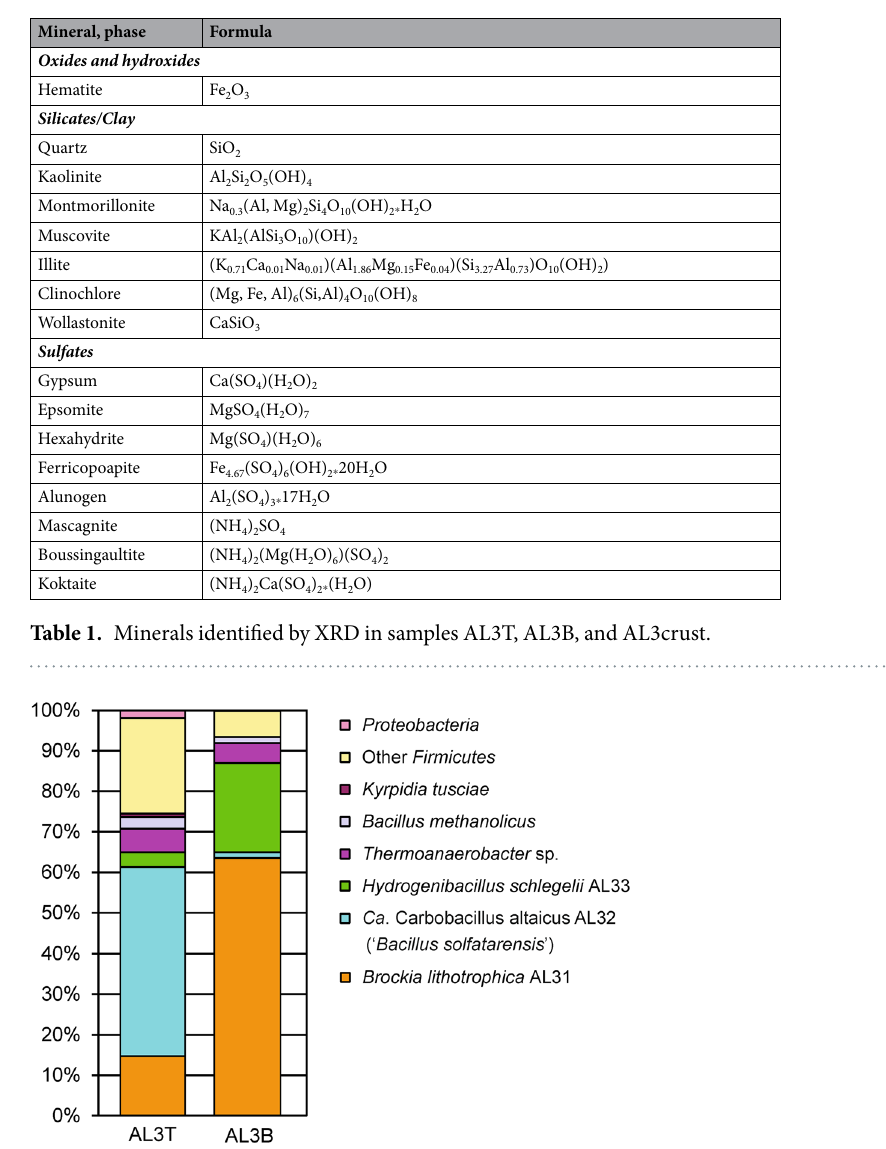
Figure 3. The relative abundance of taxonomic groups of microorganisms in the ground sample (AL3T) and in the bituminous substance (AL3B). Note that the name Ca . Carbobacillus altaicus AL32 was proposed for a newly identified lineage phylogenetically related to’ Bacillus solfatarensis